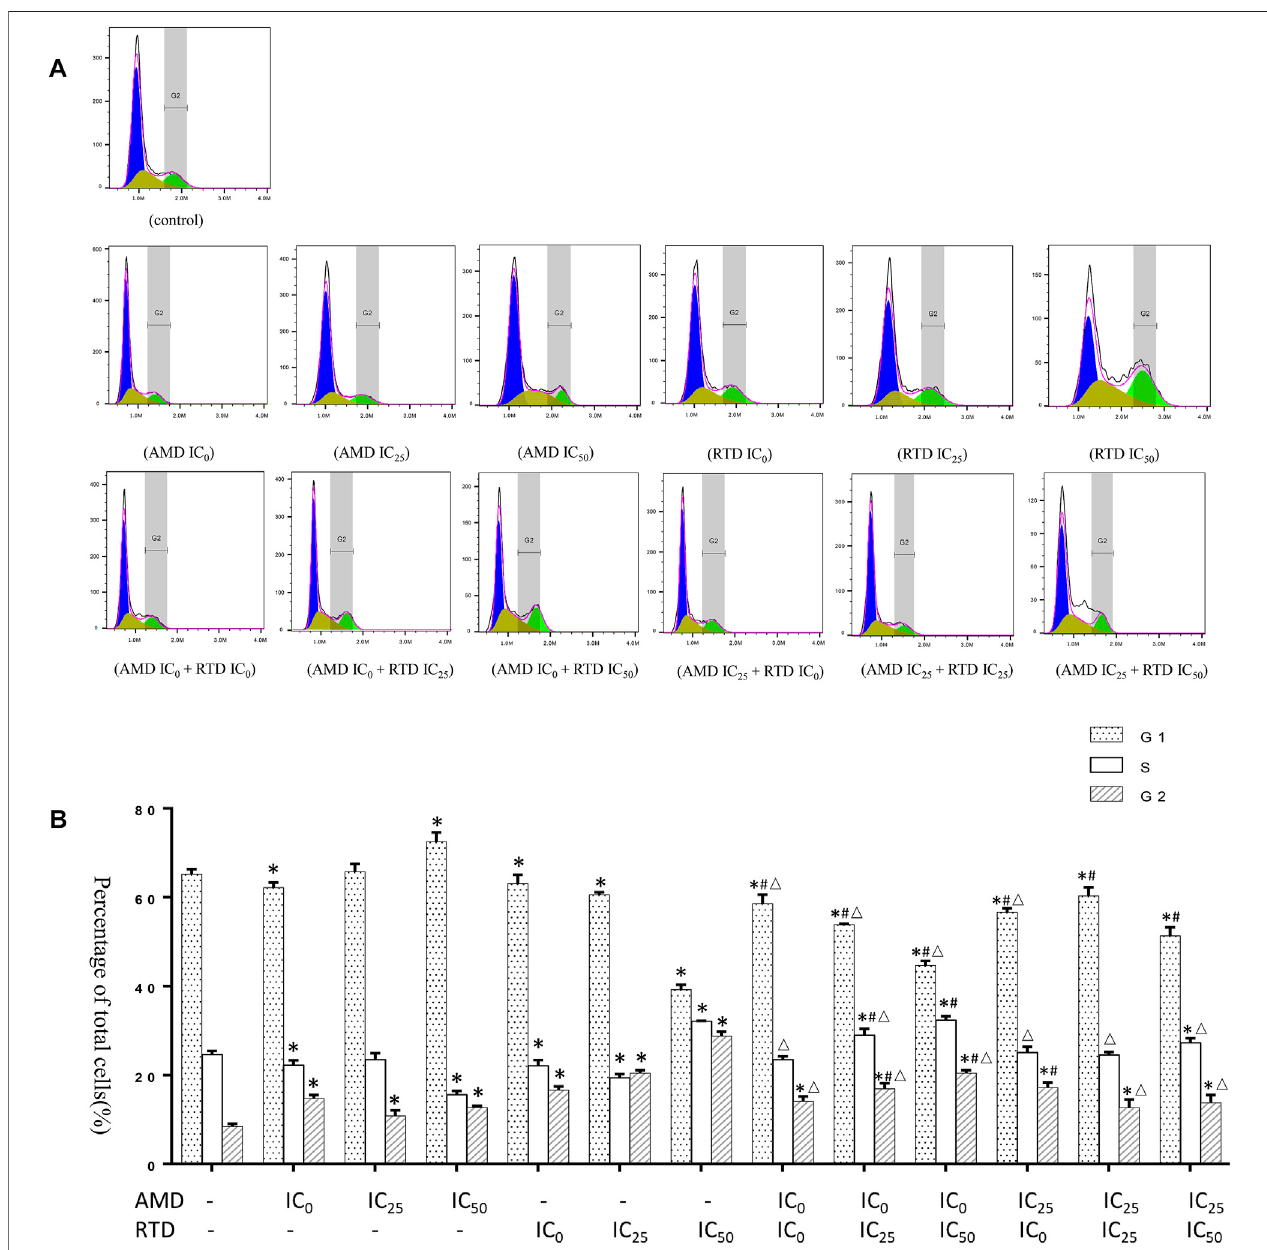
FIGURE 5 | Effects of AMD, RTD, and their compatibility on A375 cell cycle. (A) Flow analysis result of A375 cell cycle. (B) Statistical histogram of A375 cell cycle resulst. n = 3. p p < 0.05, compared with the control group. # p < 0.05, compared with the corresponding AMD group. △ p < 0.05, compared with the corresponding RTD